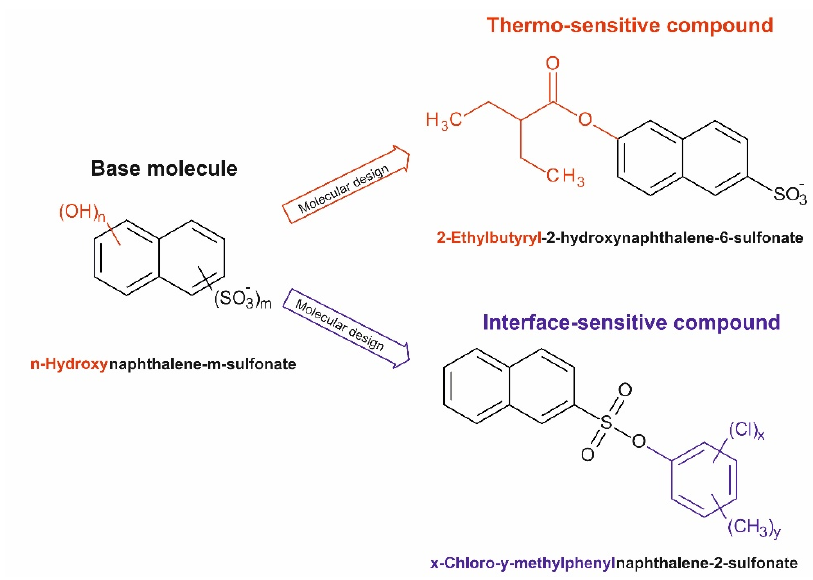
Figure 3. Design of two different types of potential reservoir tracers based on naphthalenesulfonate as common structural element.